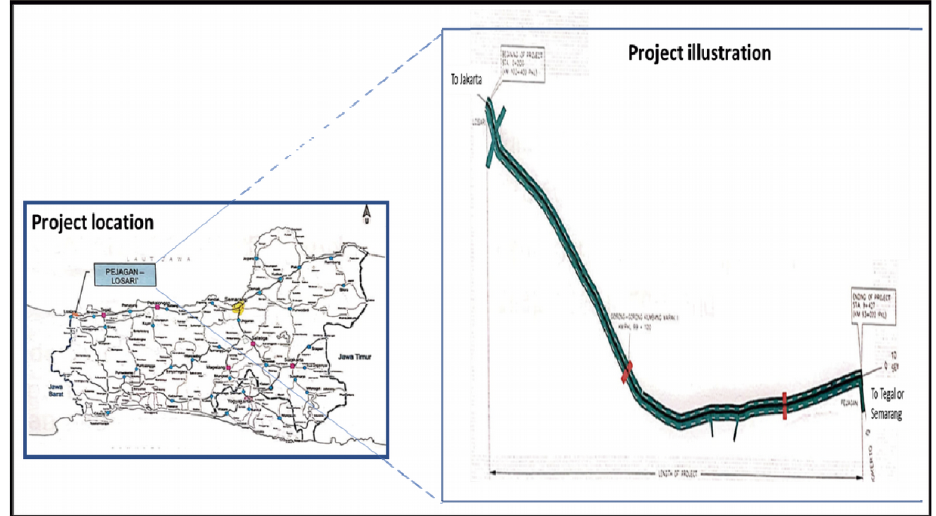
Figure 5. Losari-Penjagaan Highway